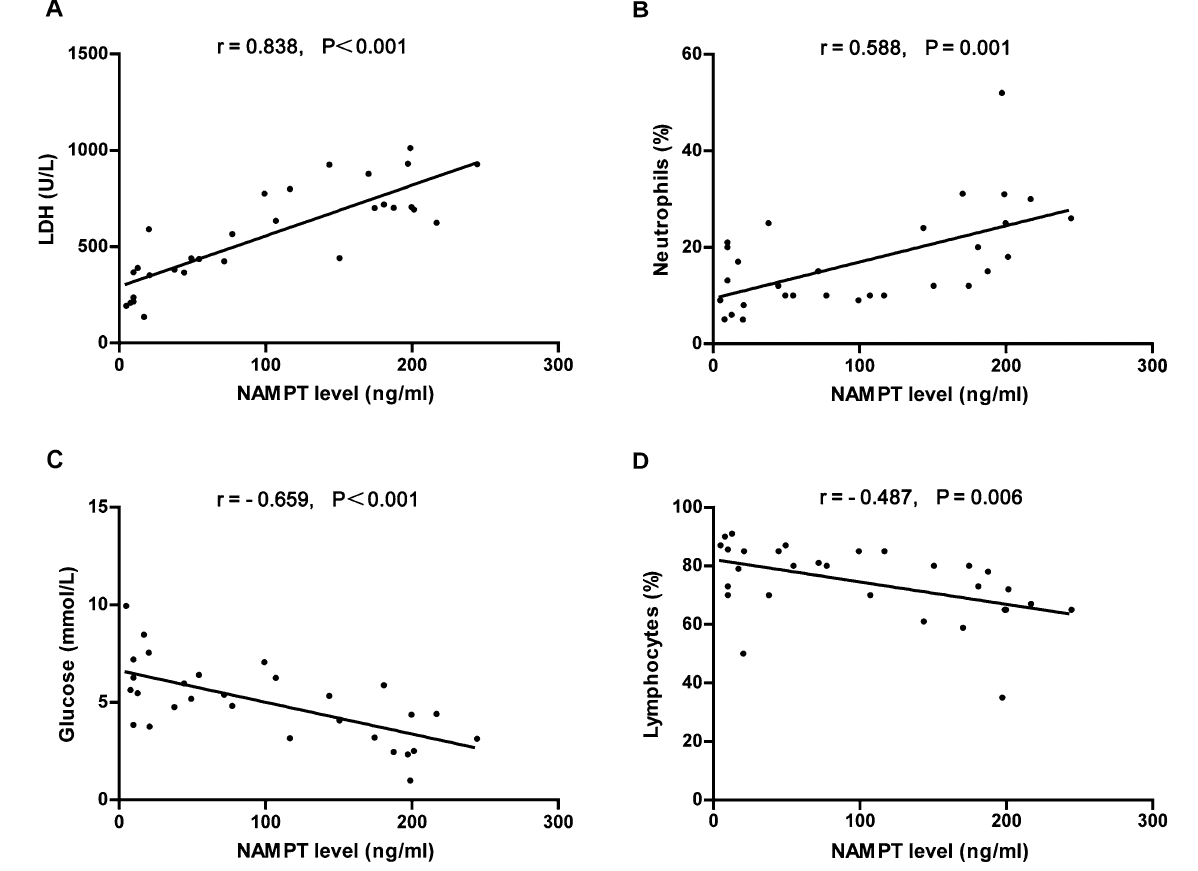
Figure 4. Correlation between pleural fluid NAMPT levels and LDH levels, neutrophil percentage, glucose levels, and lymphocyte percentage in tuberculous pleural effusions.